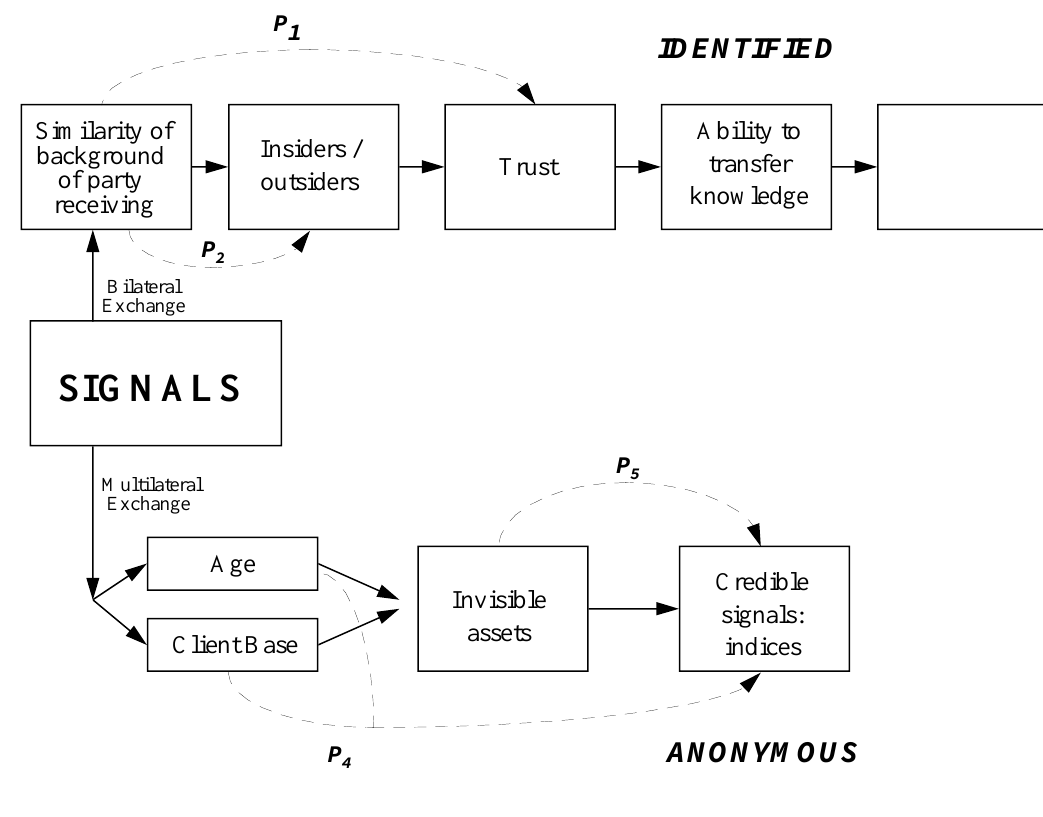
Figure 1. Signals, Invisible Assets and